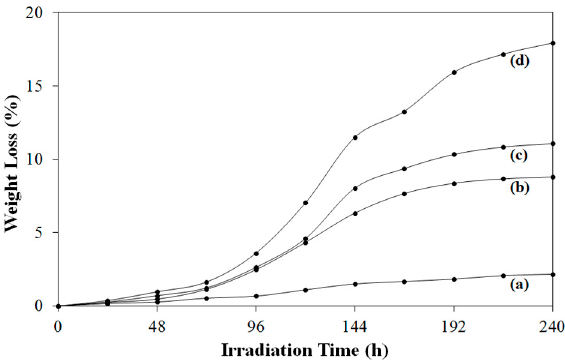
Figure 5. Weight loss of ( a ) pure PVB, ( b ) PVB/TiO 2 (5 wt.%) composite, ( c ) PVB/TiO 2 (10 wt.%) composite and ( d ) PVB/TiO 2 (15 wt.%) composite under UV irradiation as the function of time in air.